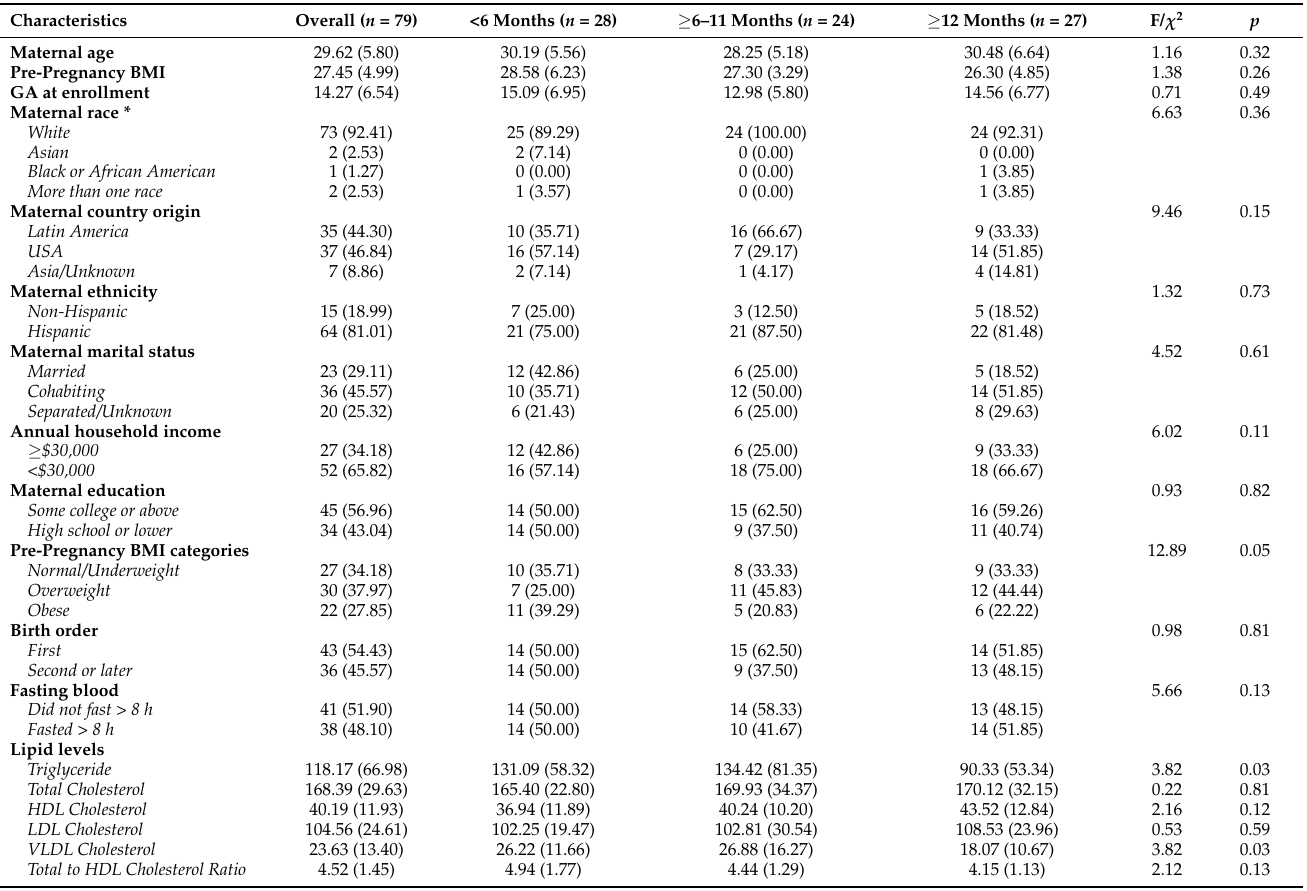
Table 1. Sample characteristics by breastfeeding duration among 79 MADRES